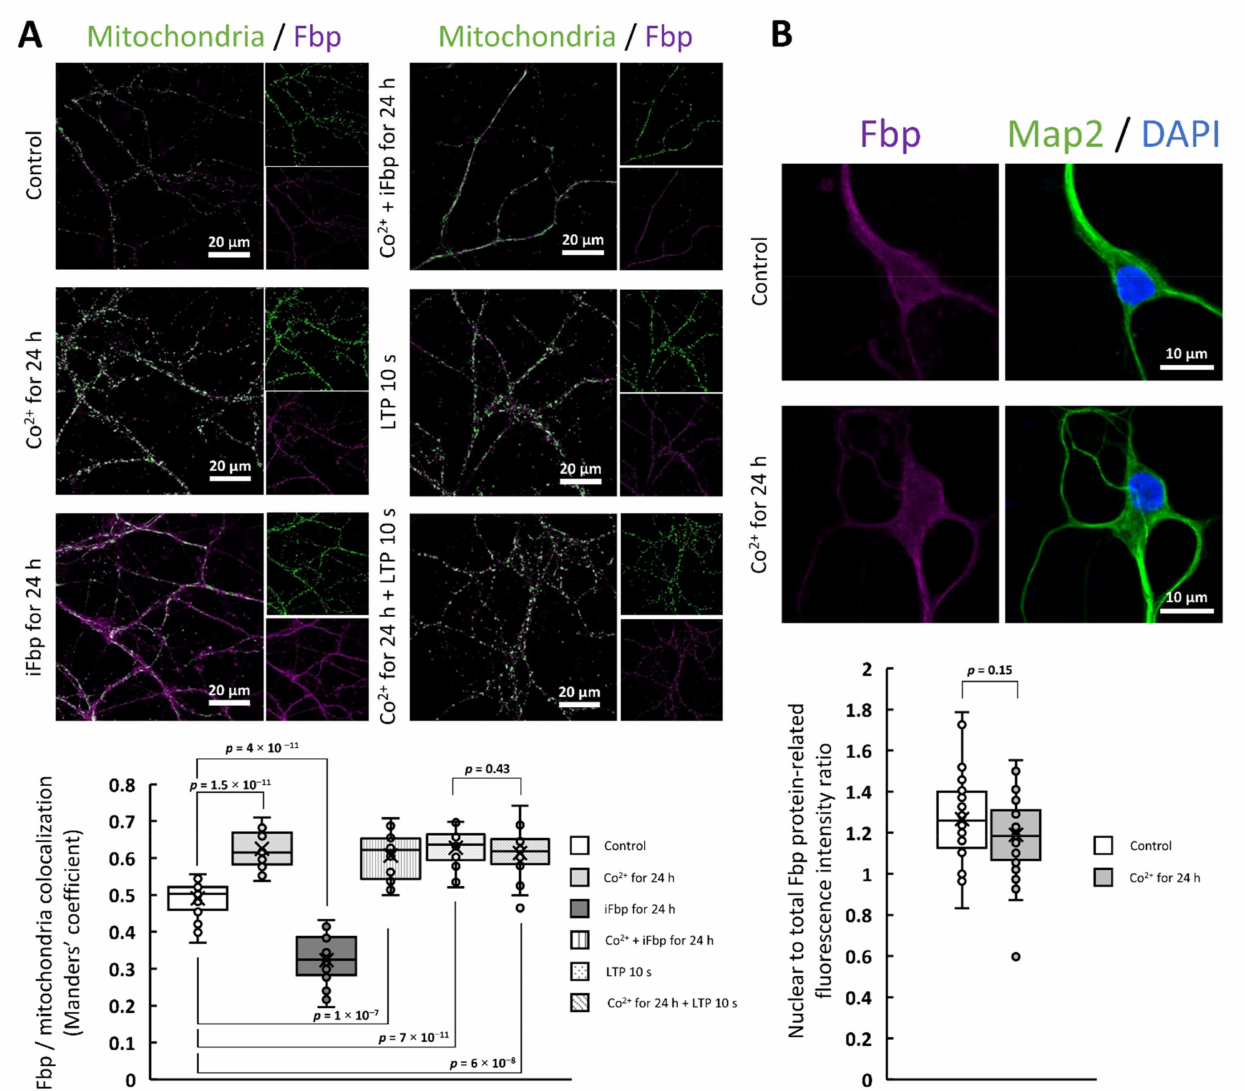
Figure 1. Co 2+ stimulates Fbp2 association with mitochondria but it does not alter the nuclear accumulation of the protein. ( A ) Fbp-mitochondria colocalization is significantly increased in Co 2+ -treated neurons both in the presence and in the absence of Fbp inhibitor (iFbp). In the presence of Co 2+ , the amount of mitochondria-bound Fbp is as high as after the LTP induction. The iFbp-treated neurons show reduced colocalization compared to control cells. ( B ) Co 2+ treatment does not change the nuclear accumulation of Fbp in